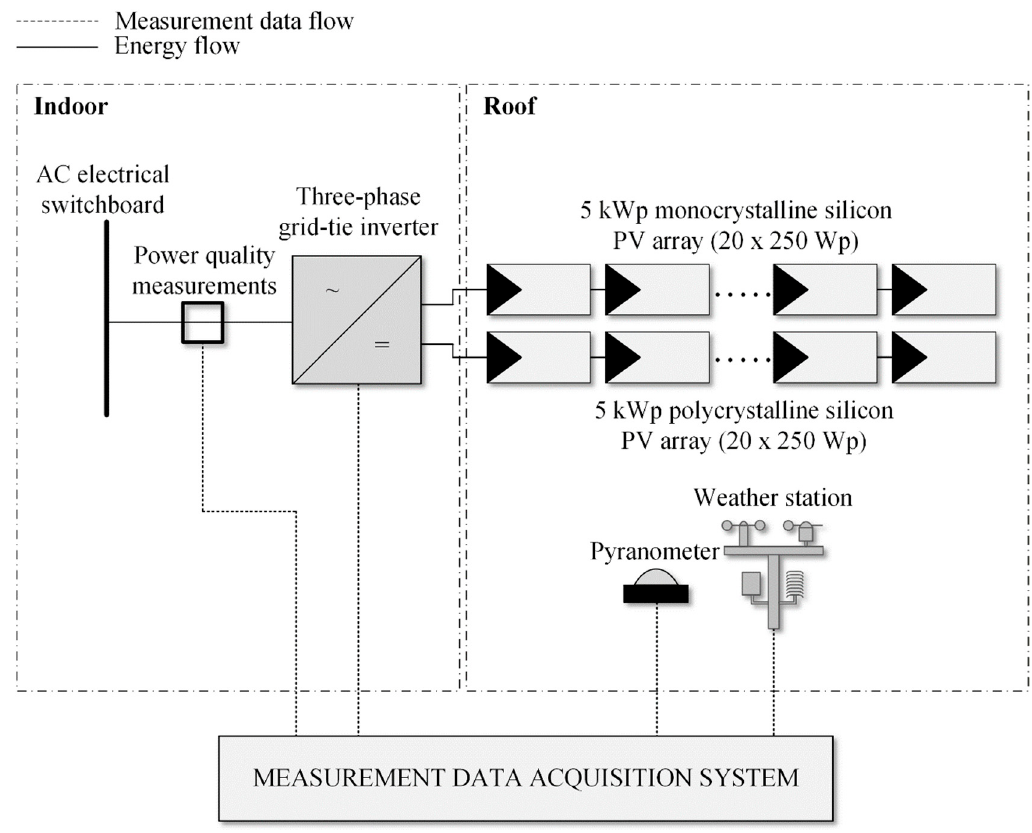
Figure 1. Scheme of the 10-kWp PV plant and part of the data acquisition system used for the measurements.